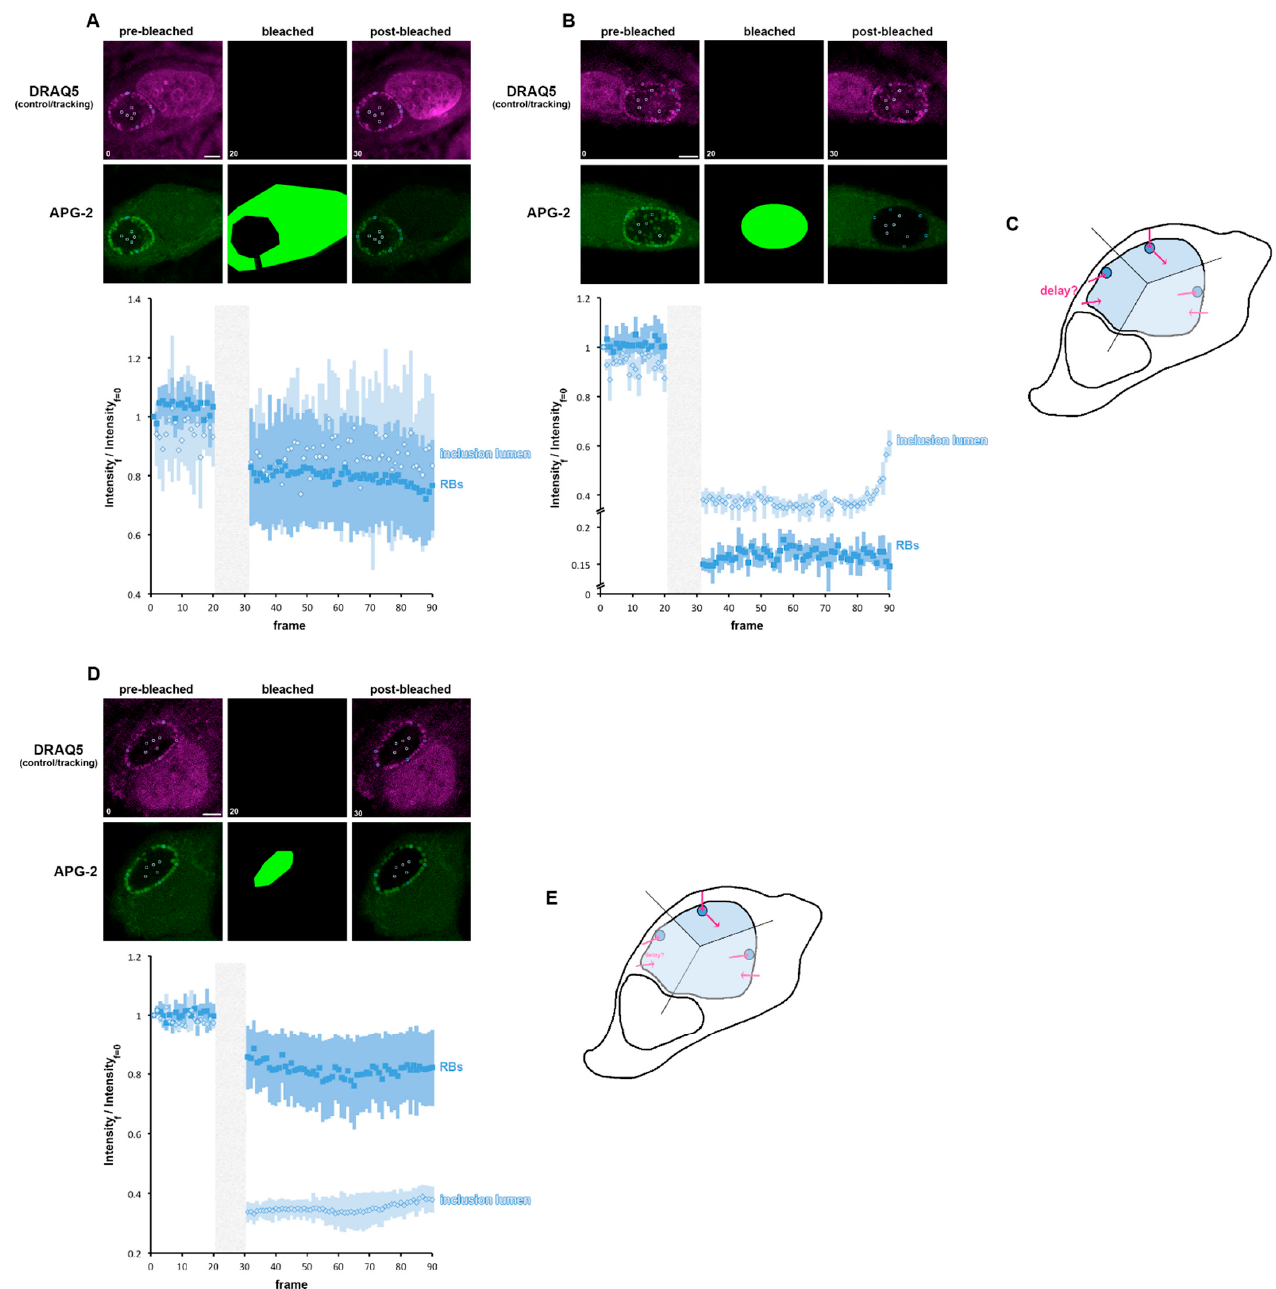
Figure 7. K + flux is controlled by the reticulate body. ( A , B ) HeLa cells were infected with C. trachomatis LGV2. At 24 hpi cells were labelled with APG-2 and DRAQ-5 and then imaged. APG-2 was photobleached as indicated on the upper panels in the cytoplasm ( A ) or in the whole inclusion ( B ). Circles show the regions of interest used for the analysis of the intensity depending on the frame (lower panels: 1.509 s/frame) presented on the lower panels. Dark blue: reticulate bodies (RBs) and light blue for the inclusion lumen. Scale bar: 5 µm. ( C ) schematics showing the proposed K + flux (pink arrows) between the host cytoplasm (white) the inclusion lumen (light blue) and the bacteria (dark blue). ( D ) HeLa cells were infected with C. trachomatis LGV2. At 24 hpi cells were labelled with APG-2 and DRAQ-5 and then imaged. APG-2 was photobleached in the inclusion lumen. ( E ) schematics showing the proposed K + flux (pink arrows) between the host cytoplasm (white) the inclusion lumen (light blue) and the bacteria (dark blue).